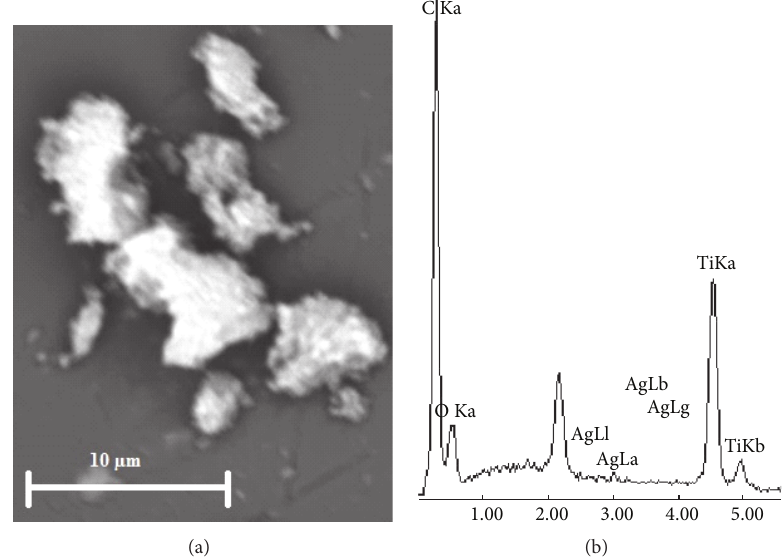
Figure 2: (a) SEM image of Ag/TiO 2 composite on polystyrene; (b) EDX spectrum of Ag/TiO 2